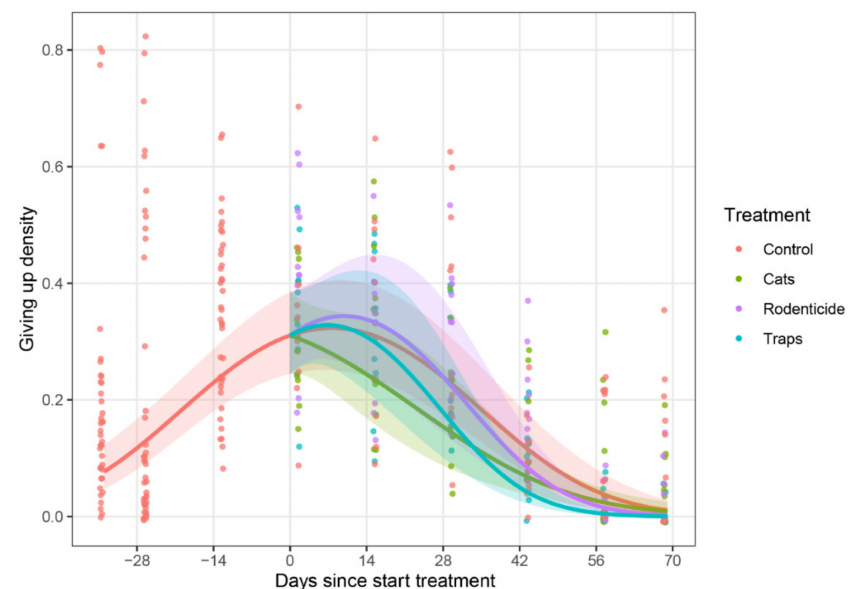
Figure 10. Percentage of peanuts eaten by rodents per day (averaged over two consecutive observation days) in a giving up density monitoring trial in the wet season of 2016. Estimated time trend lines for each treatment were generated by a generalised linear mixed model (described elsewhere) with shaded areas representing 95% confidence bands for the predicted mean response. By the end of the storage period, the number of peanuts eaten from the GUD in the trapping and rodenticide treatments was marginally lower than the number eaten in the untreated control GUD.